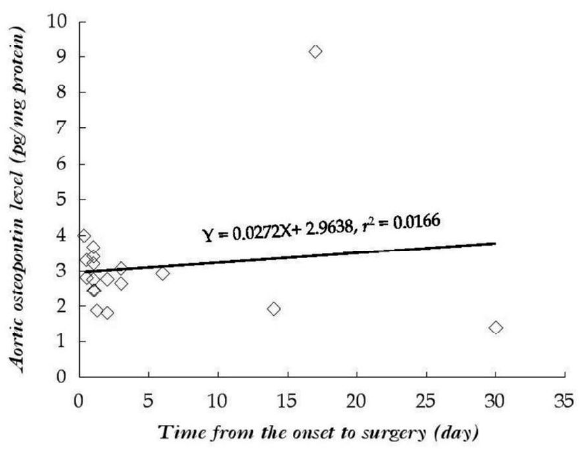
Fig. 7 - Correlation between osteopontin concentration in the aortic tissue and time interval from the onset to surgery in the patients with aortic dissection